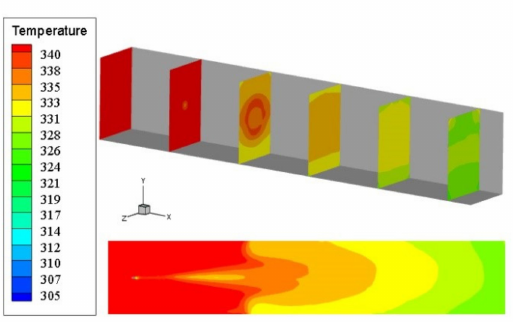
Figure 17. Air temperature nephogram of the wind tunnel.